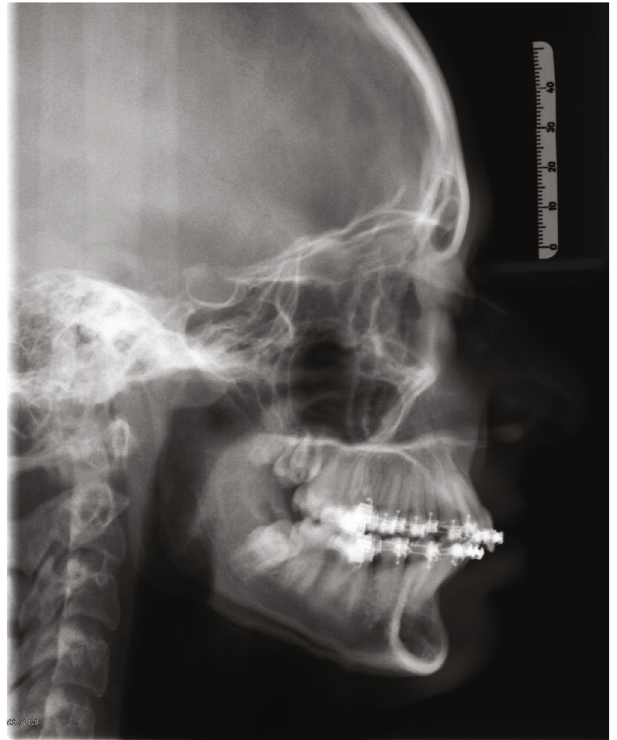
Figure 12: Post-Herbst teleradiography.